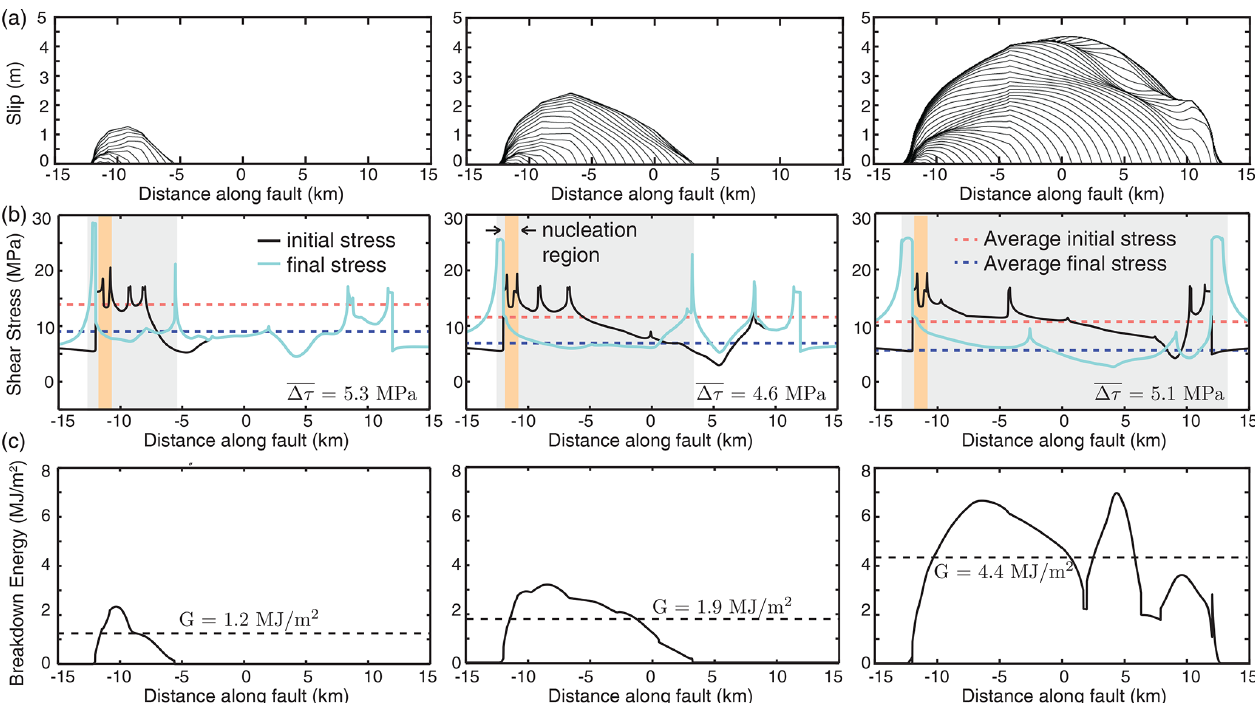
Figure 5. Comparison of three earthquake ruptures of different sizes nucleating over the same fault area. (a) Slip distributions for the three ruptures. (b) Distributions of initial (solid black) and final (solid blue) shear stress for the three ruptures. Gray shading denotes the ruptured region, and orange shading denotes the region where each rupture nucleates. The dashed red and blue lines denote the average initial and final shear stress in the ruptured region. Large events have smaller initial and smaller final average stress, resulting in similar stress drops. (c) Distribution of breakdown energy (solid black) and average breakdown energy for each event (dashed line). The average breakdown energy generally increases with the rupture